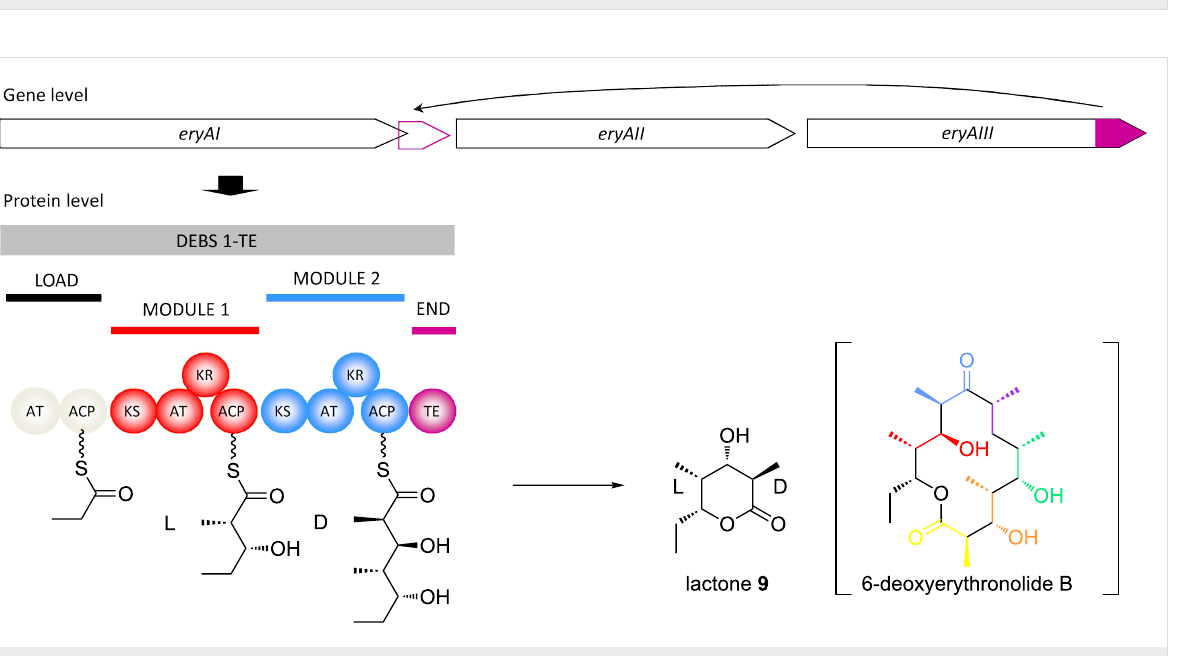
for elucidating the origin of the two configurations. In the pres- ence of a suitable starter unit such as propionyl-CoA, (2 R )- methylmalonyl-CoA as extender unit and NADPH (the cofactor for the KR domains), no product was observed. However, when (2 S )-methylmalonyl-CoA was provided instead, the product was obtained at a satisfactory rate, showing that both